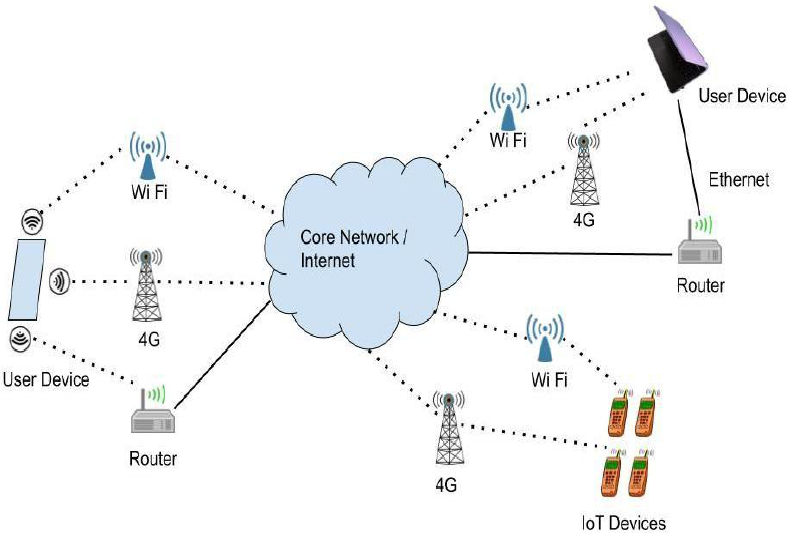
Figure 1. Multi-homed user devices.